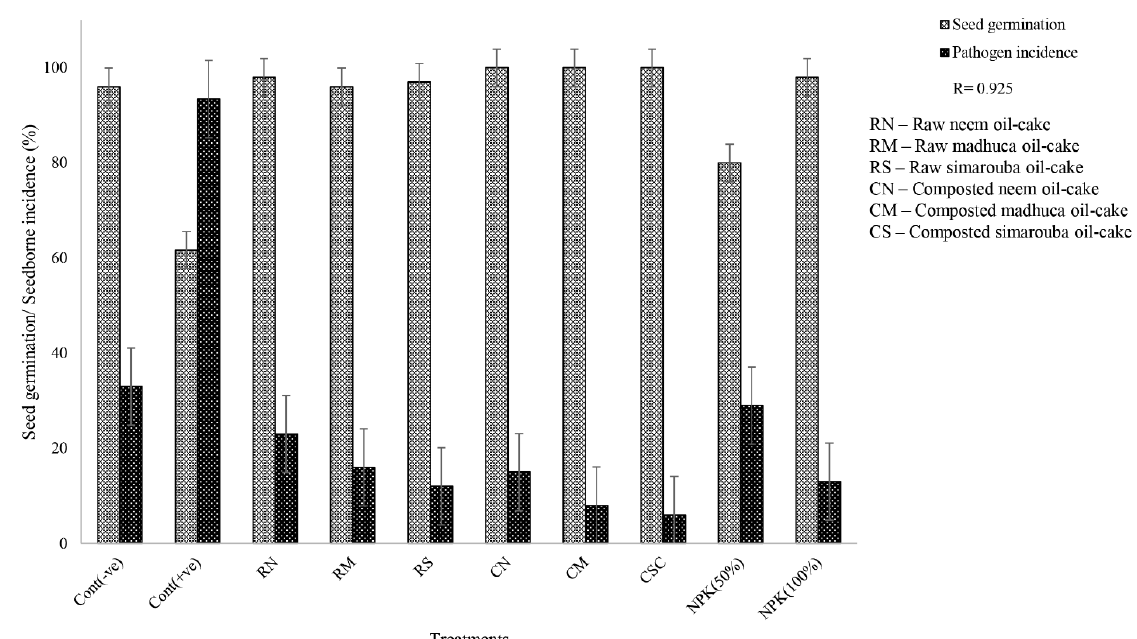
Fig. 4 Effect of soil amendment with raw or composted oil-cakes of neem, madhuca and simarouba on seed germi- nation (%) and seedborne incidence (%) of Alternaria tenuissima in chilli in the